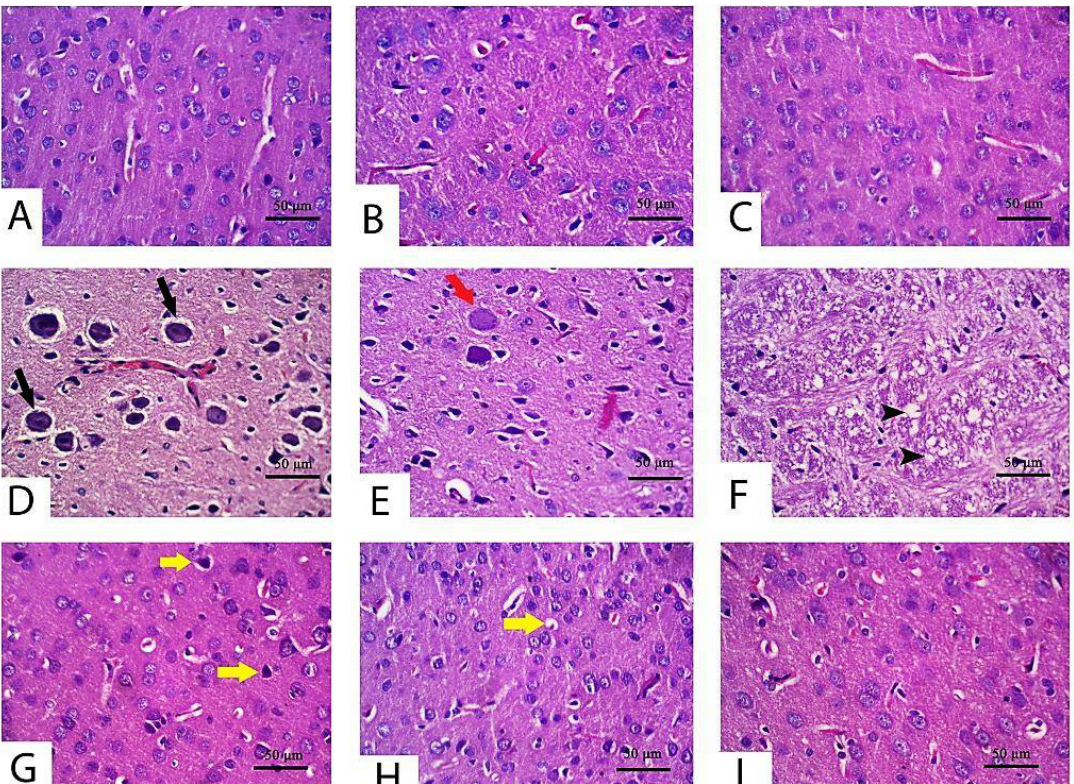
Figure 3. Histopathology of the cerebrum in control and CPF, TQ, and LP treated groups (H&E stain). Apparently, normal neurons were observed in control ( A ), TQ ( B ) and LP ( C ) treated rats with null to minimal apoptotic neurons. ( D – F ) Cerebral cortex of CPF-treated rats showing neuronal degeneration (tigrolysis; black arrow) ( D ), central chromatolysis (red arrow) ( E ) and neuropile vacuolation (black arrowhead) ( F ). A low number of shrunken apoptotic neurons (yellow arrows) was observed in TQ ( G ), LP ( H ) and combination ( I ) groups co-treated with CPF.